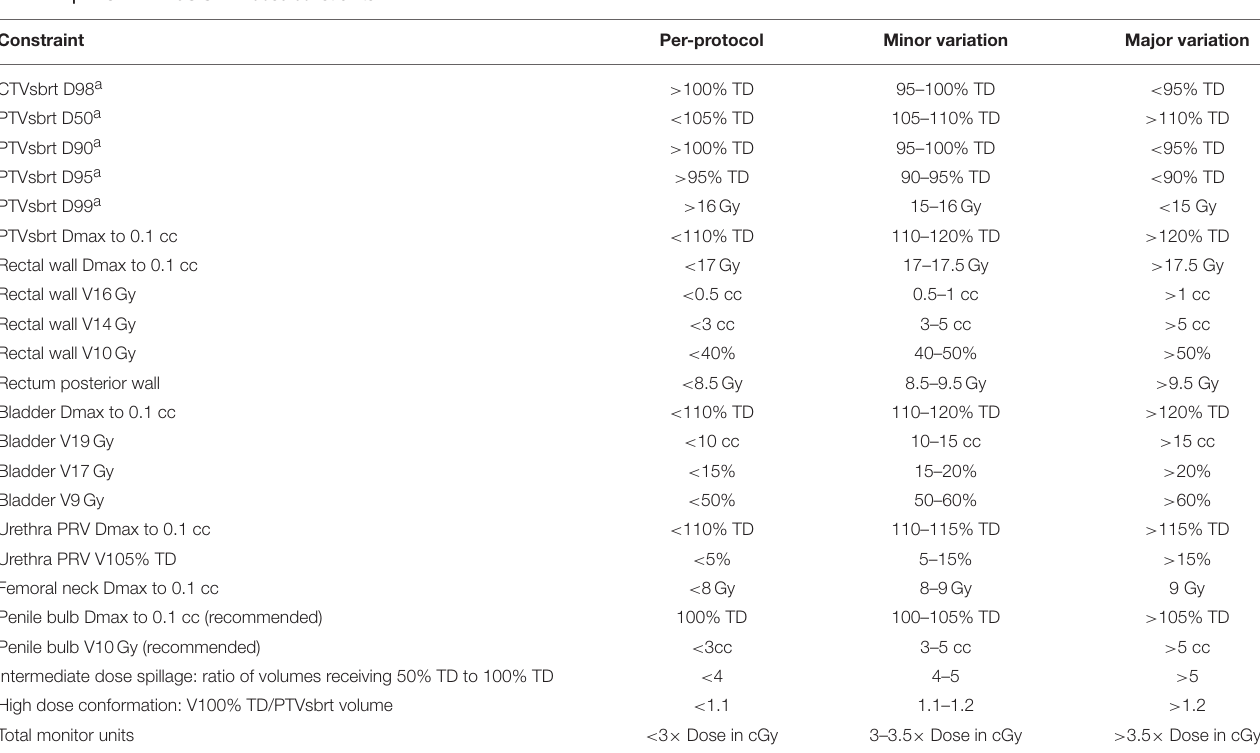
TABLE 1 | PROMETHEUS SBRT dose